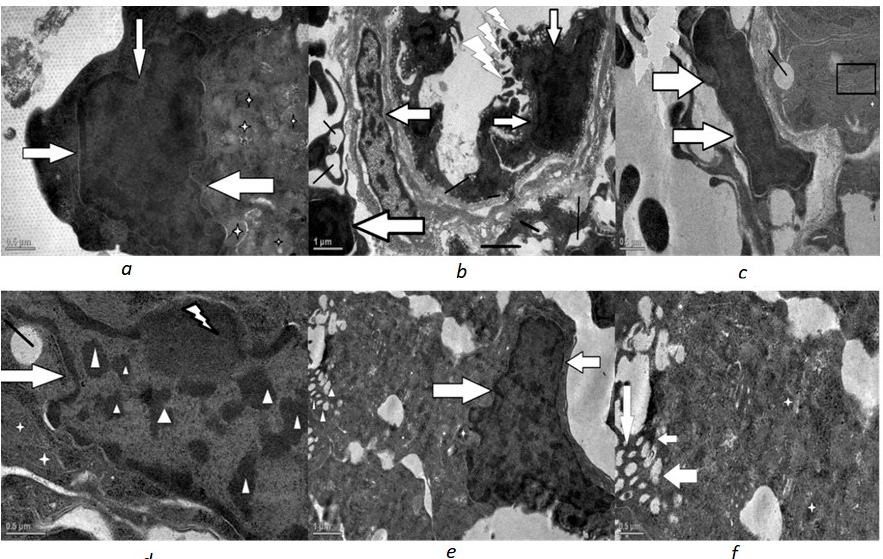
Figure 3. Transmission electron micrographs of 0.6 mg/L Phorate exposed renal cells exposed for 72 h: ( a ) deformed nucleus (white head arrow) and other structures not distinct, mitochondria (star) (scale 1 µm); ( b ) electron dense deposits in deformed nucleus (white filled arrow), deformed fused swollen pedicels (flashed white arrow) and extreme vacuole presence(thick black line) (scale 1 µm). ( c , d ) transmission electron micrographs of 0.005mL/L Dimethoate exposed renal cells exposed for 72 h: ( c ) degenerated nucleus with electron dense deposits throughout nucleoplasm (white filled arrow); condensed degenerated mitochondria (star), vacuole (thick black line) and curved degener- ated ER ( □ ) (scale 0.5 µm); ( d ) deformed nucleus (white filled arrow) with condensed electron dense chromatin (arrow head) and peripheral nucleolus (flashed white arrow), presence of vacuoles(thick black line) (scale 0.5 µm) ( e , f ) transmission electron micrographs of 0.01 mL/L Dimethoate exposed renal cells exposed for 72 h: ( e ) less distinct cytoplasmic structures-deformed nucleus (white filled arrow), degenerated mitochondria (star), severe cytoplasmic vacuoles (white arrow head) (scale 1 µm); ( f ) extreme vacuolation (white filled arrow) and electron dense degenerated mitochondria (star) (scale 0.5 µm).